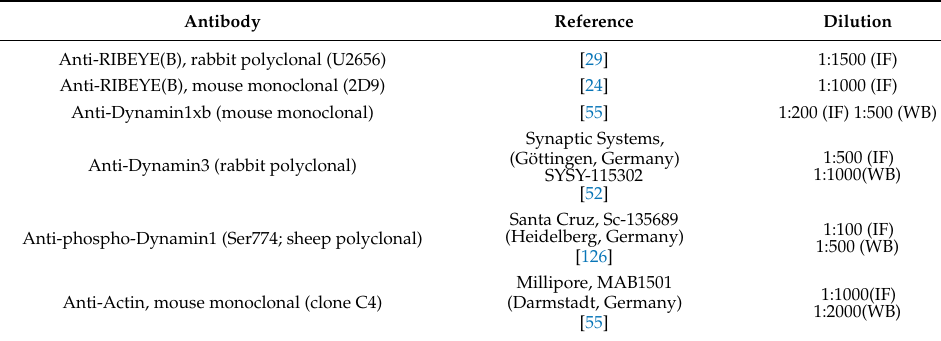
Table 1. Primary